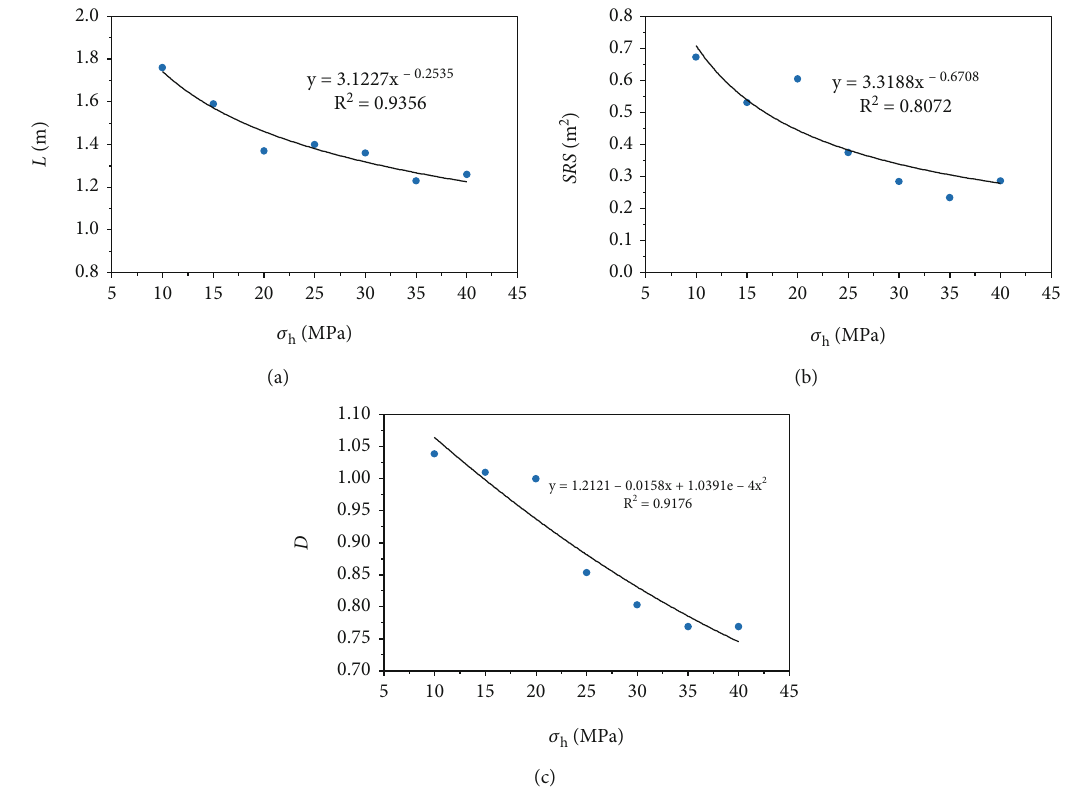
Figure 18: HF propagation morphology under di ff erent minimal horizontal